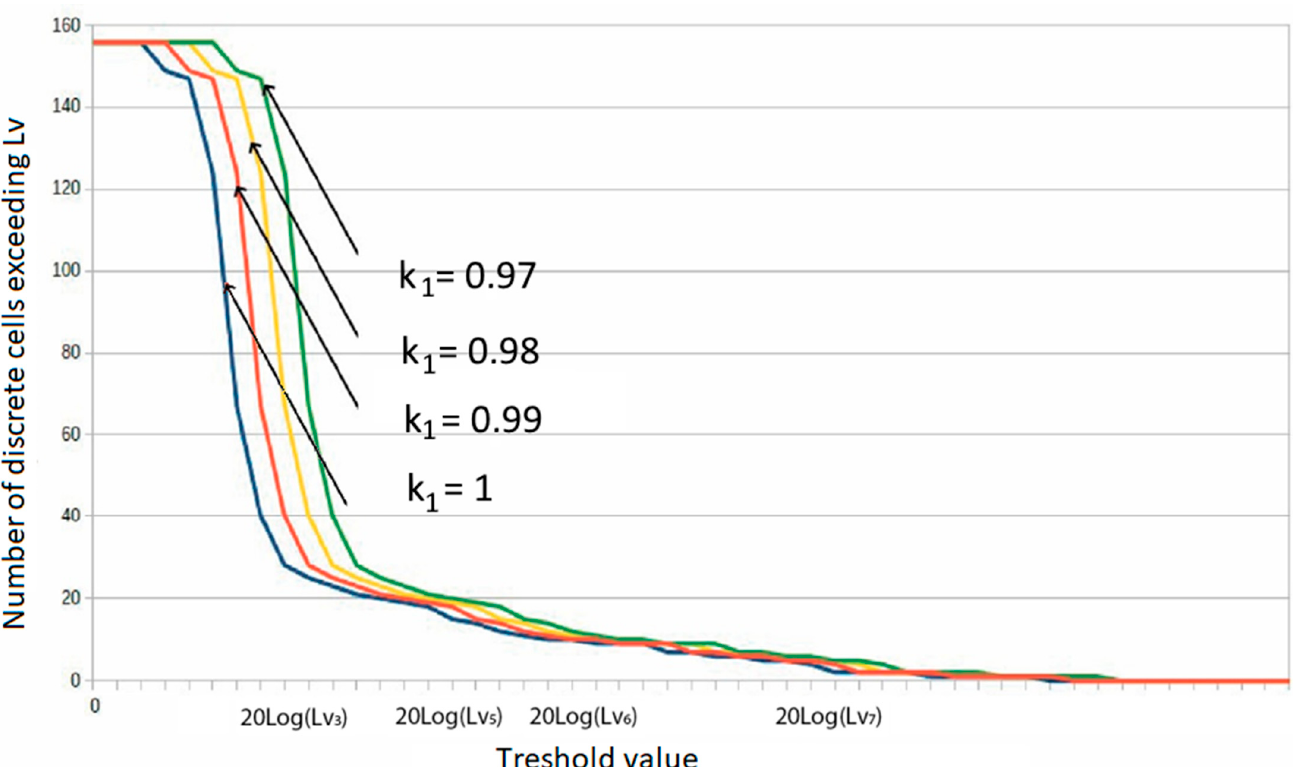
Figure 11. Dependence of the number of detected defects on the value of L v for different values of the coefficient k 1 .